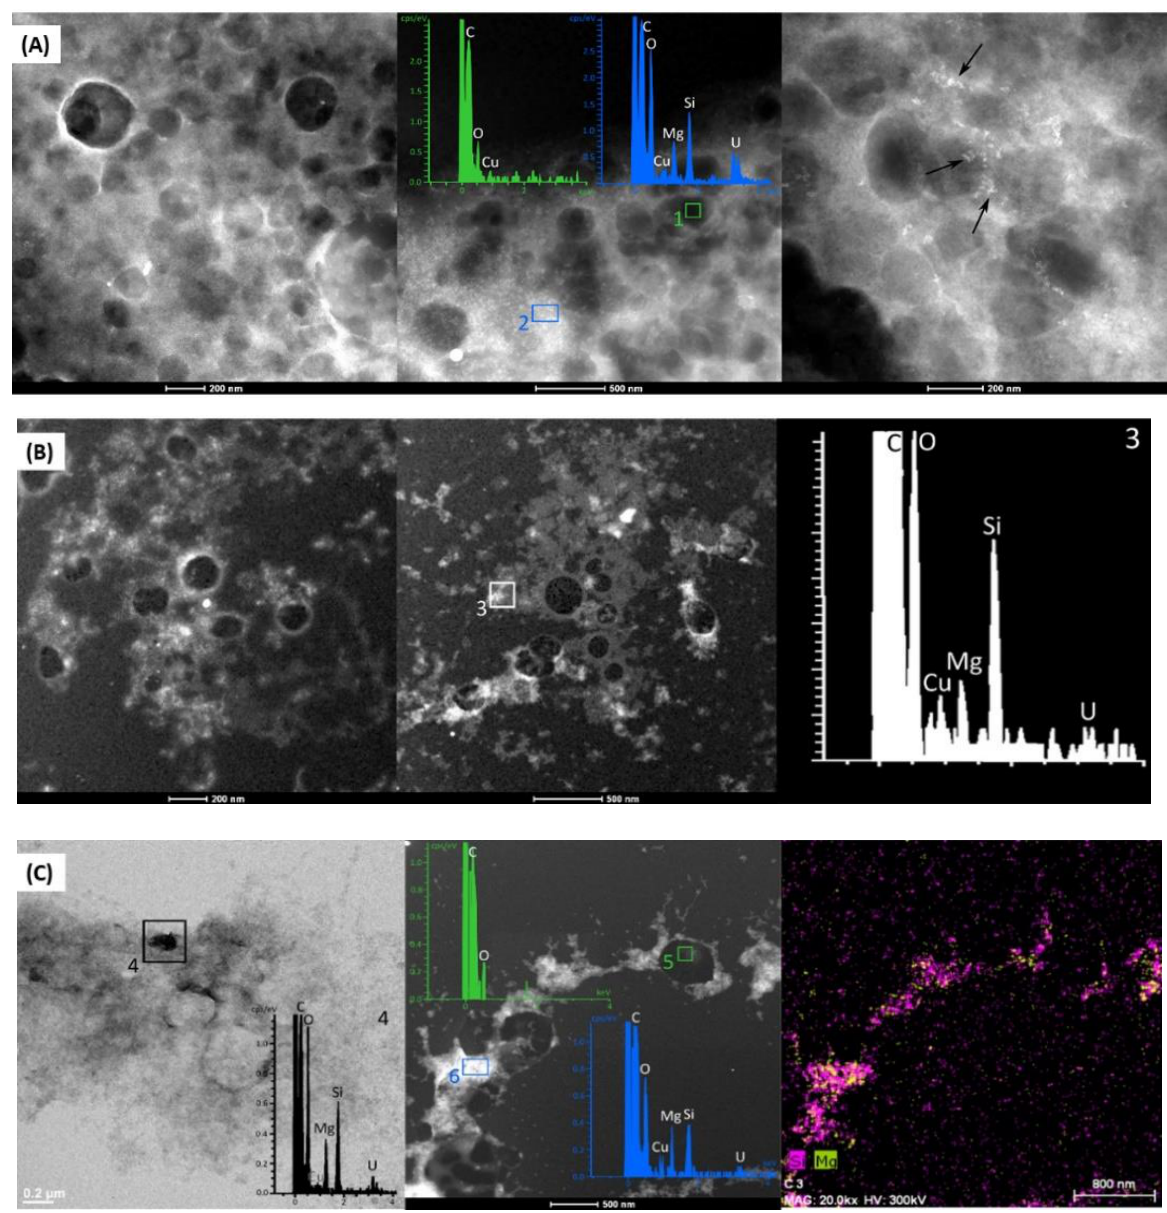
Figure 6. UHRTEM microphotographs, XEDS analyses, and elemental X-ray maps of MMn_L ( A ), MMn2_L ( B ), and MMn4_L ( C ). Scale bars = 200 nm.